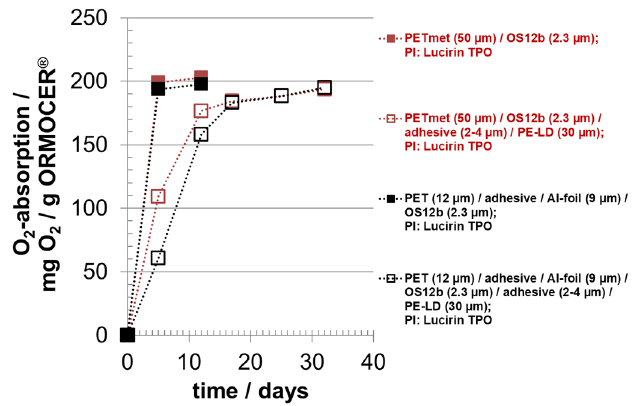
Figure 5. Oxygen absorption of oxygen scavenger ‘ORMOCER ® OS12b’ with photo-initiator (PI) Lucirin TPO; curing time: 5 min; OS coating thickness (dry) around 2.3 µm; with and without sealing layer PE-LD.